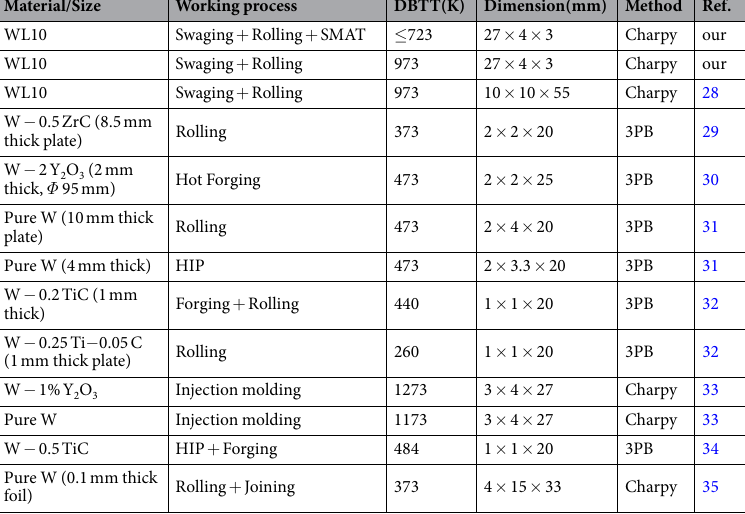
Table 4. Comparison between the present and previously reported data related to the DBTT of tungsten-based